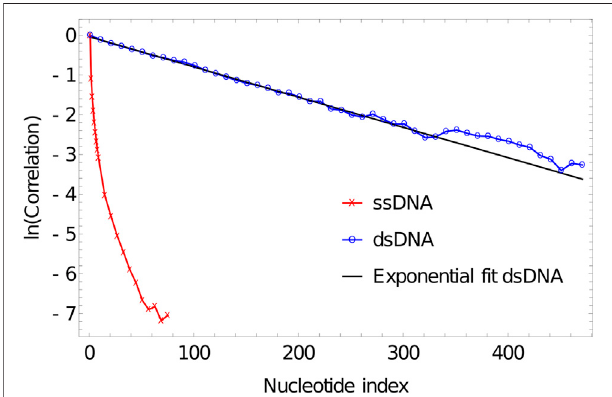
FIGURE 5 | Log plot of correlation of inter-segment vectors vs distance (number of base pairs along the DNA) for 500 dsDNA (blue curve) and 100ssDNA (red curve). dsDNA fi tted with an exponential decay with a decay constant of